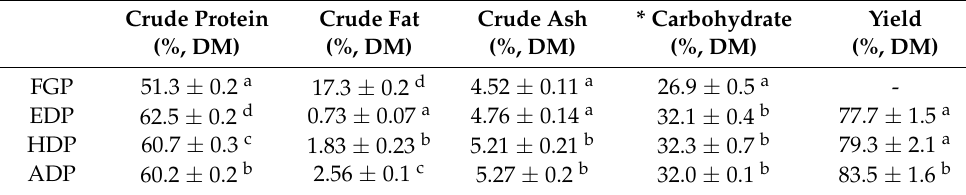
Table 1. Proximate analyses of G. bimaculatus and three defatted protein concentrates.